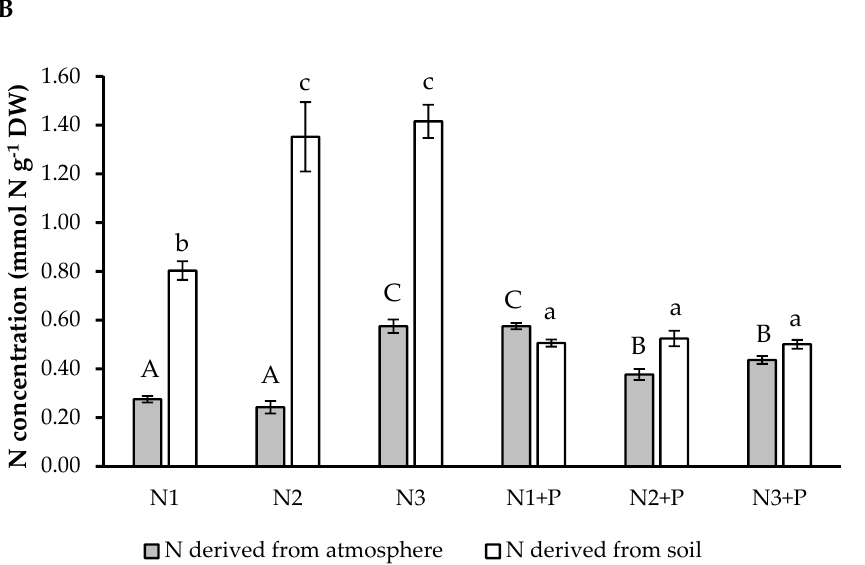
Figure 3. N preferences ( A ) Percentage N derived from the atmosphere, ( B ) Plant N concentration derived from atmosphere and Plant N concentration derived from soil (mmol N g − 1 DW)) of 180-day-old L. leucocephala saplings grown in Veld Fertilizer Trial soils from Ukulinga Experimental Farm, South Africa. Values represent the means ± SE, based on n = 5. Significant differences among treatments ( p < 0.05) are denoted by different superscript letters.